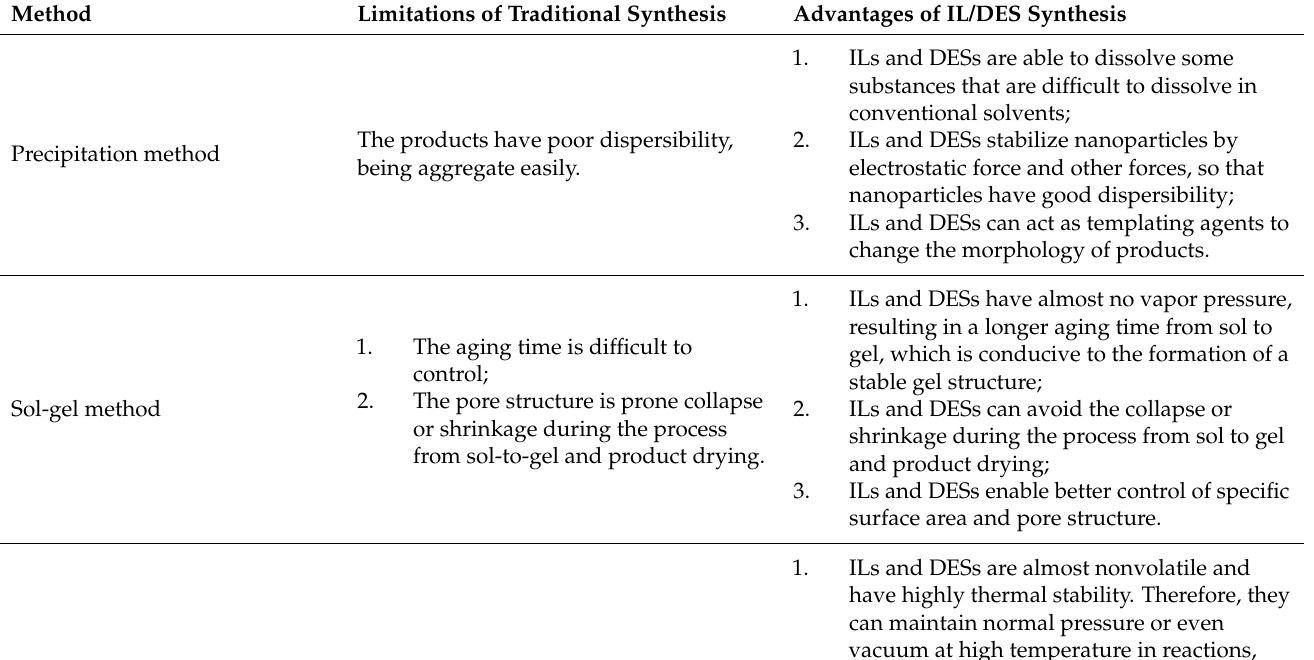
Table 3. Comparative of the advantages of IL/DES synthesis over traditional